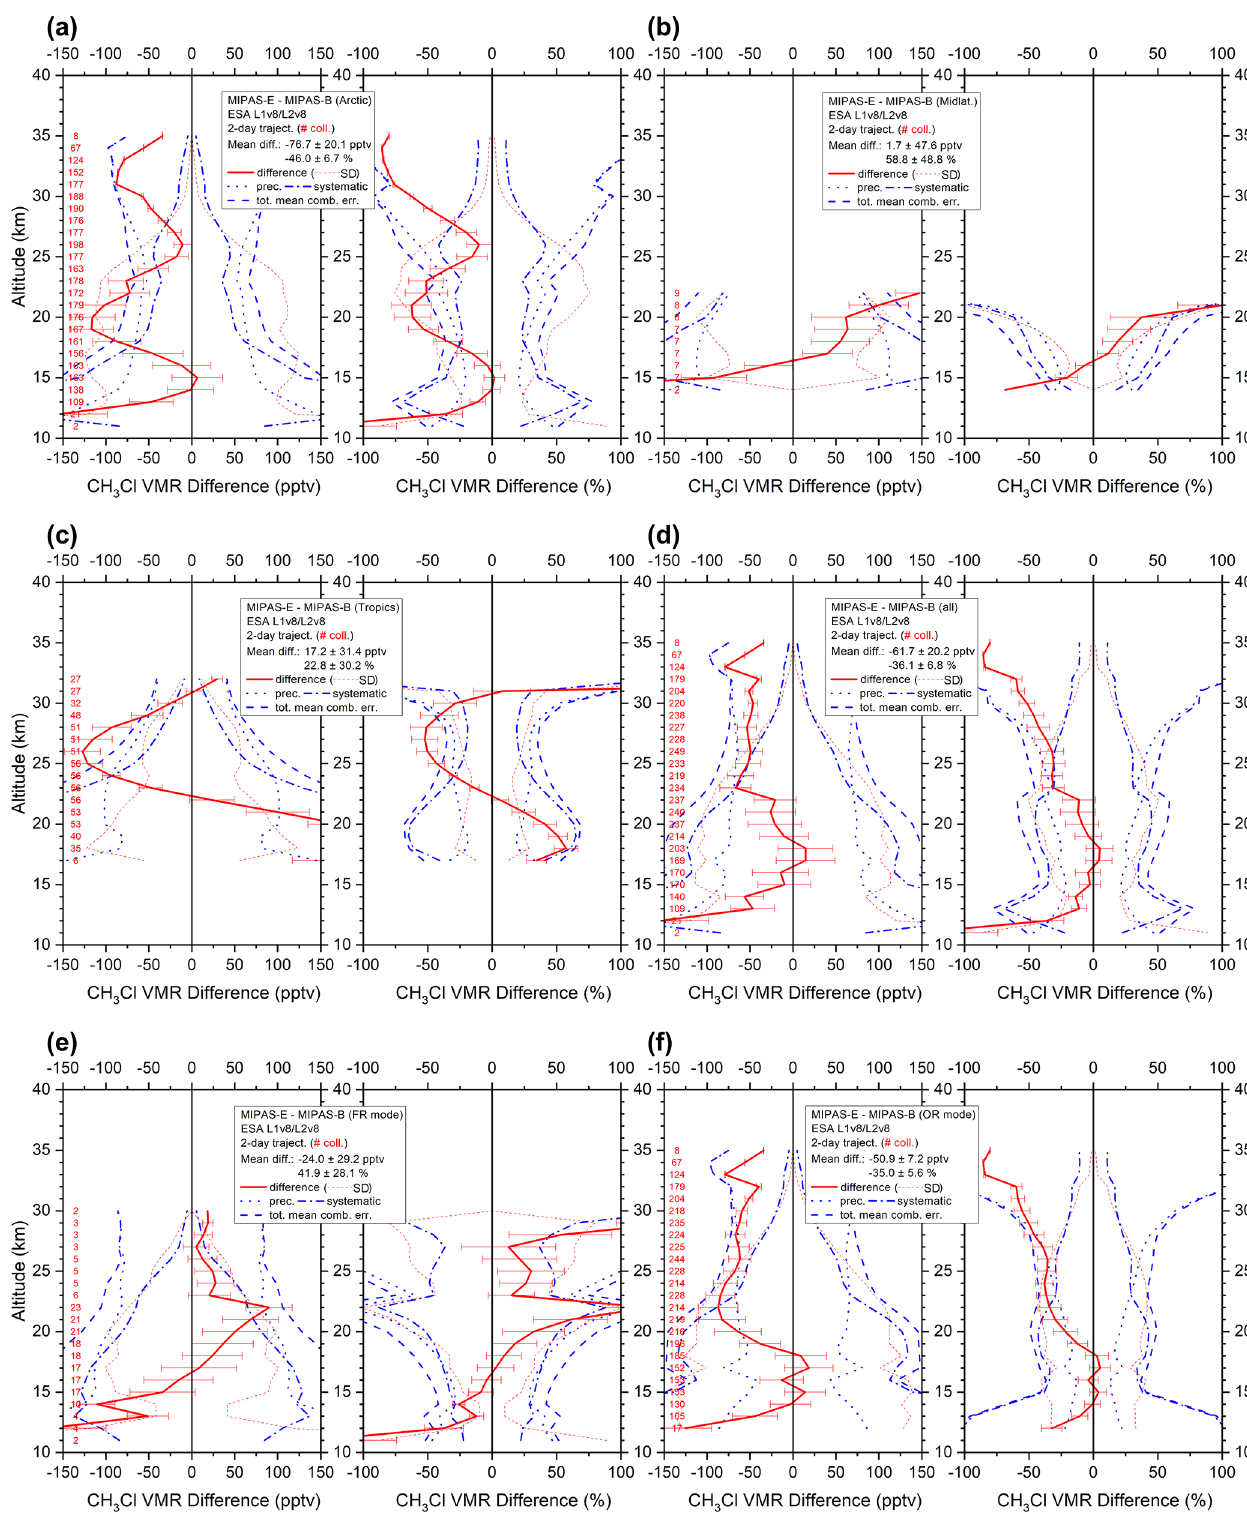
Figure 22. Same as Fig. 3 but for CH 3